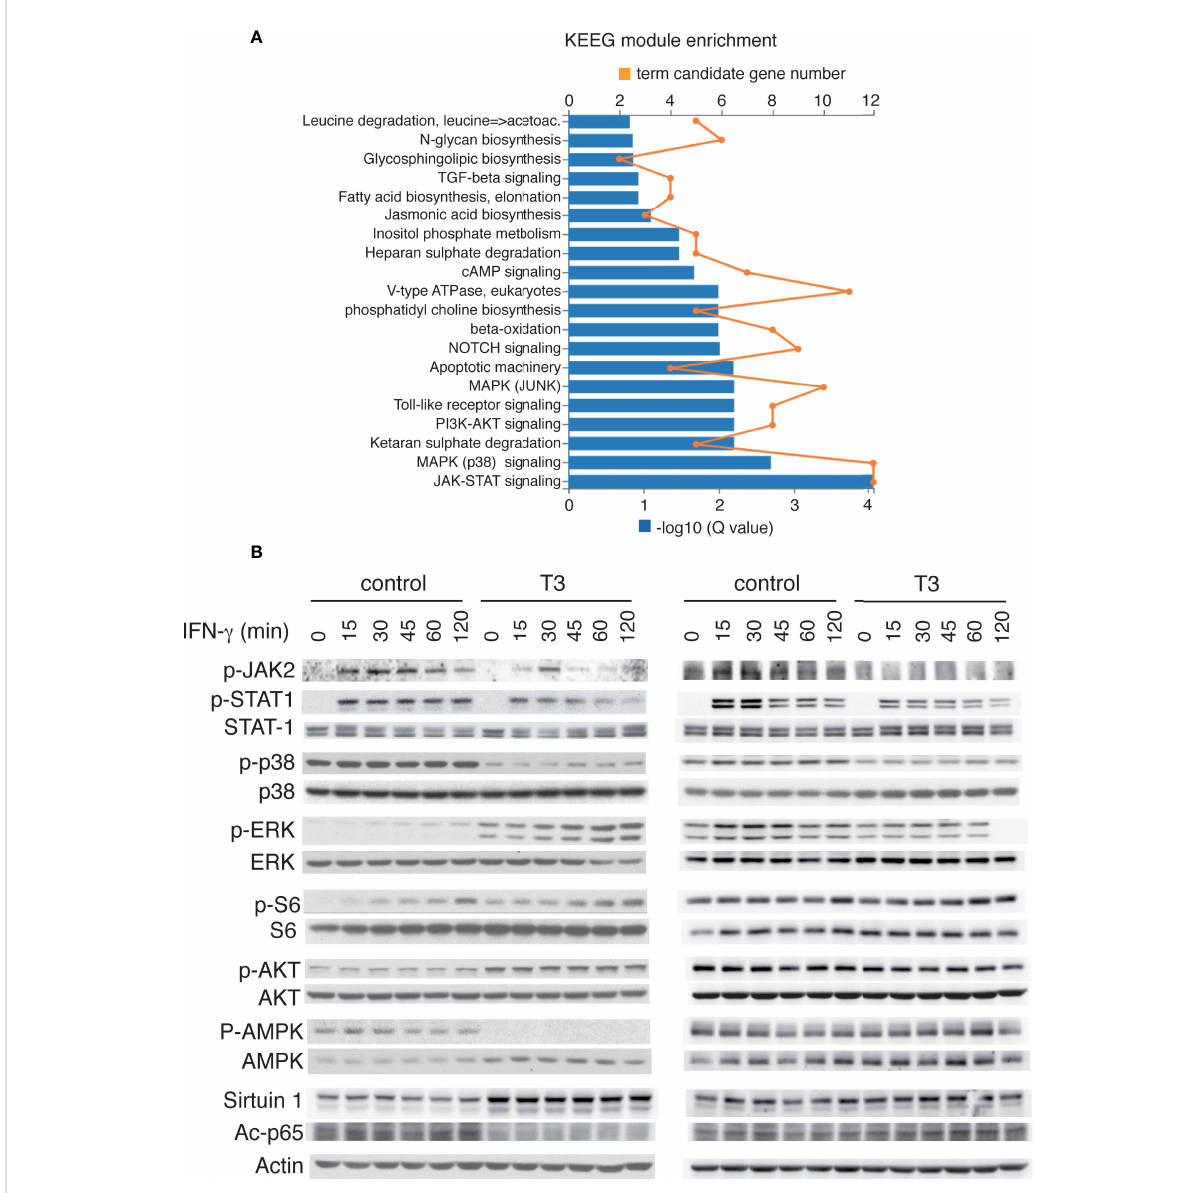
FIGURE 8 T3 inhibits JAK/STAT activation by IFN g in immortalized and primary bone marrow-derived macrophages. (A) KEEG module enrichment in transcripts down-regulated by T3 in I-BMBM, showing that JAK/STAT and p38 MAPK modules are the two most down-regulated terms. Both the term candidate transcript number (in orange) and the Q value (in blue bars) are depicted. (B) I-BMDM (left) and P-BMDM (right) plated in complete medium were shifted to hormone-depleted medium and after 5 h incubated with and without 10 nM T3 for 40 h and with 5 ng/ml IFN- g for the indicated time points. Representative western blots with the indicated antibodies are